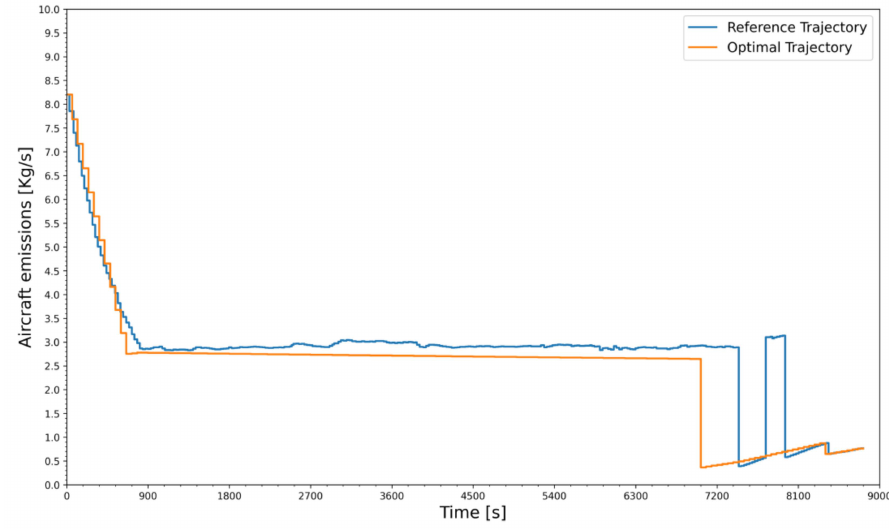
Figure 8. Comparison of emissions rate vs. time of reference and emissions-optimal trajectory.